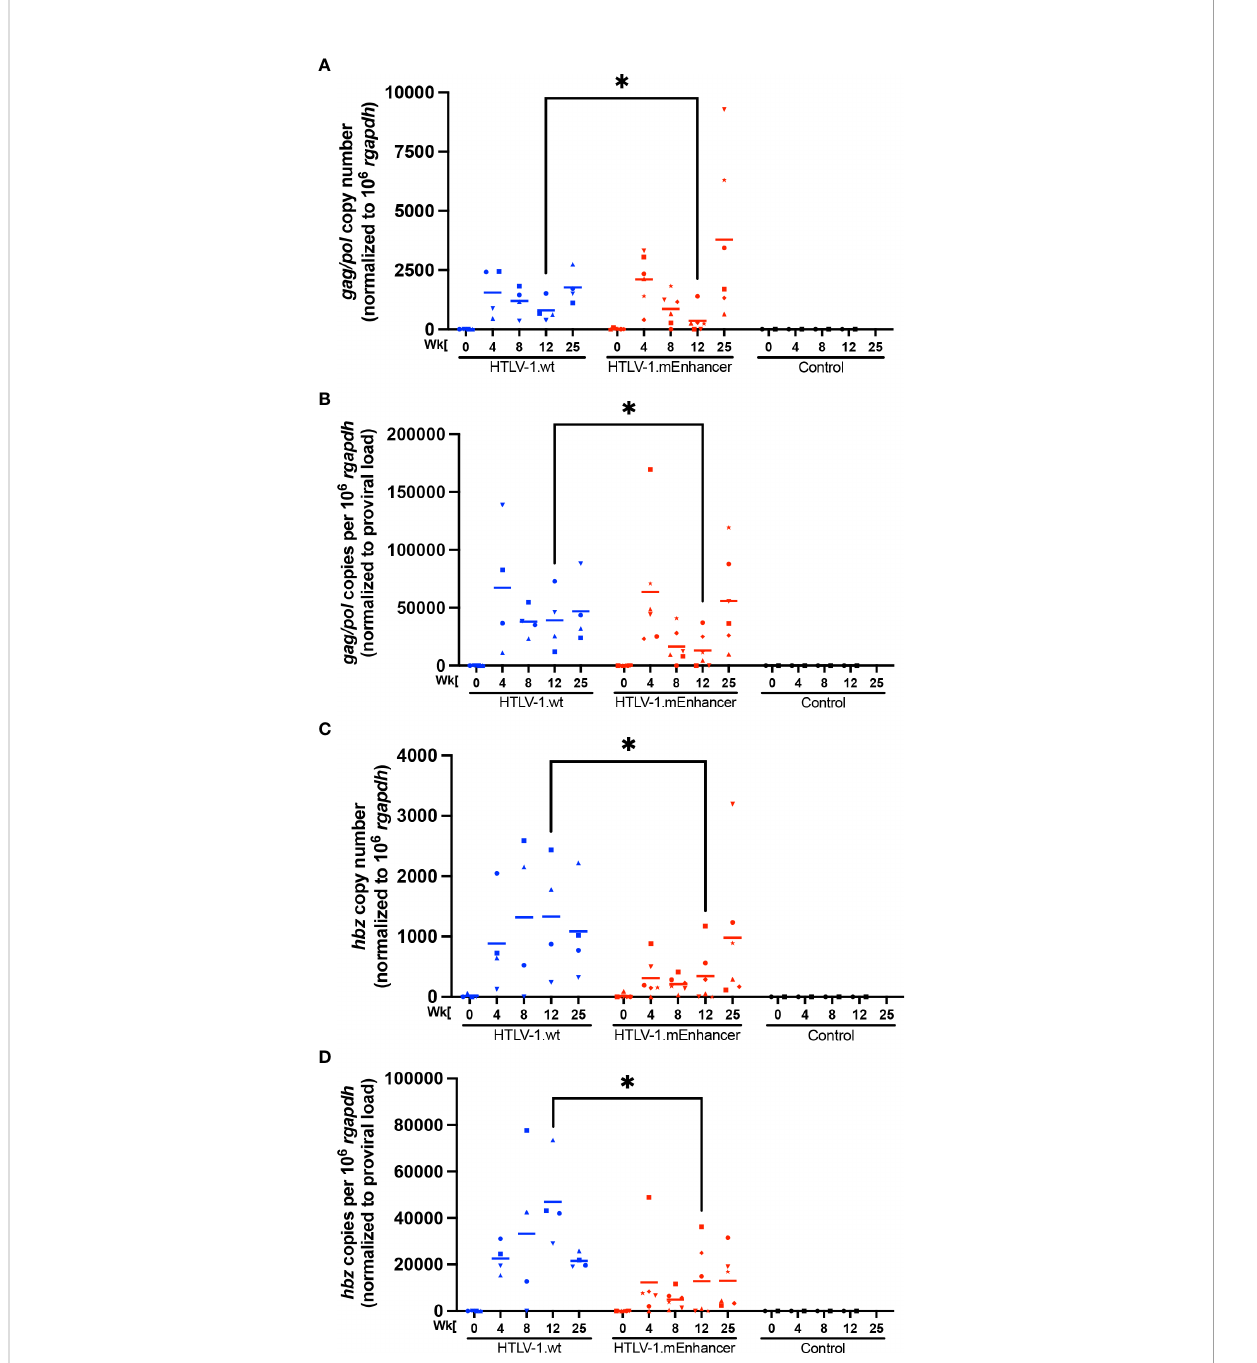
FIGURE 4 HTLV-1 enhancer element alters in vivo sense and anti-sense viral gene expression. RNA was isolated from rPBMCs for cDNA synthesis. cDNA from rabbit samples and negative controls was used in 12-cycle pre-ampli fi cation reactions. Pre-ampli fi cation products were diluted according to the manufacturer ’ s directions for qPCR to detect viral gene expression. Copy numbers of Gag/pol (A) and Hbz (C) are shown relative to 1 x 10 6 rgapdh copies. The levels of viral transcripts were evaluated by normalizing Gag/pol (B) or Hbz (D) copies per 10 6 rgapdh to proviral load. In each of the graphs, unique symbols represent gene expression for a single inoculated rabbit over time and bars represent the mean. Linear mixed-effects analyses were performed and multiple comparisons were adjusted by Tukey ’ s method. *P ≤